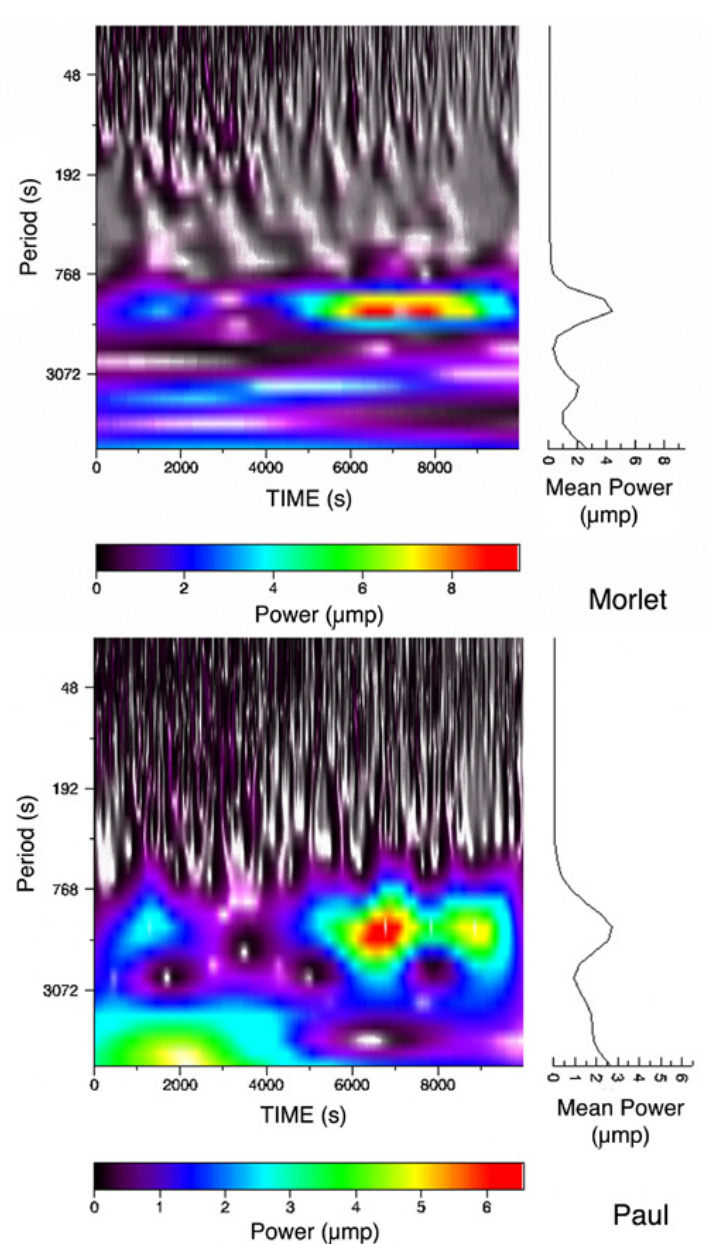
Fig. 3. The wavelet analysis of the July 24 data: the upper panel shows the output using the Morlet wavelet and the lower panel the output using the Pauli wavelet. It is very clear, especially from the Pauli wavelet, that the power related with 686 μ Hz (around 1460 s in the vertical scale which gives a period), increases considerably in the second part of the